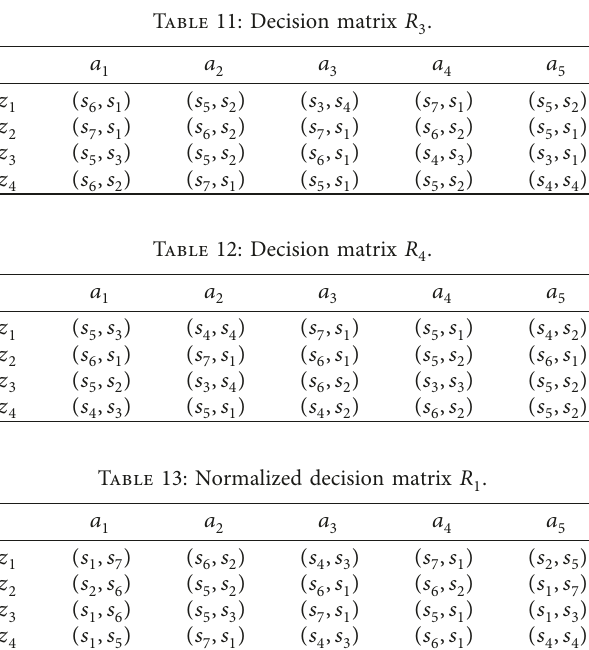
Table 11: Decision matrix R